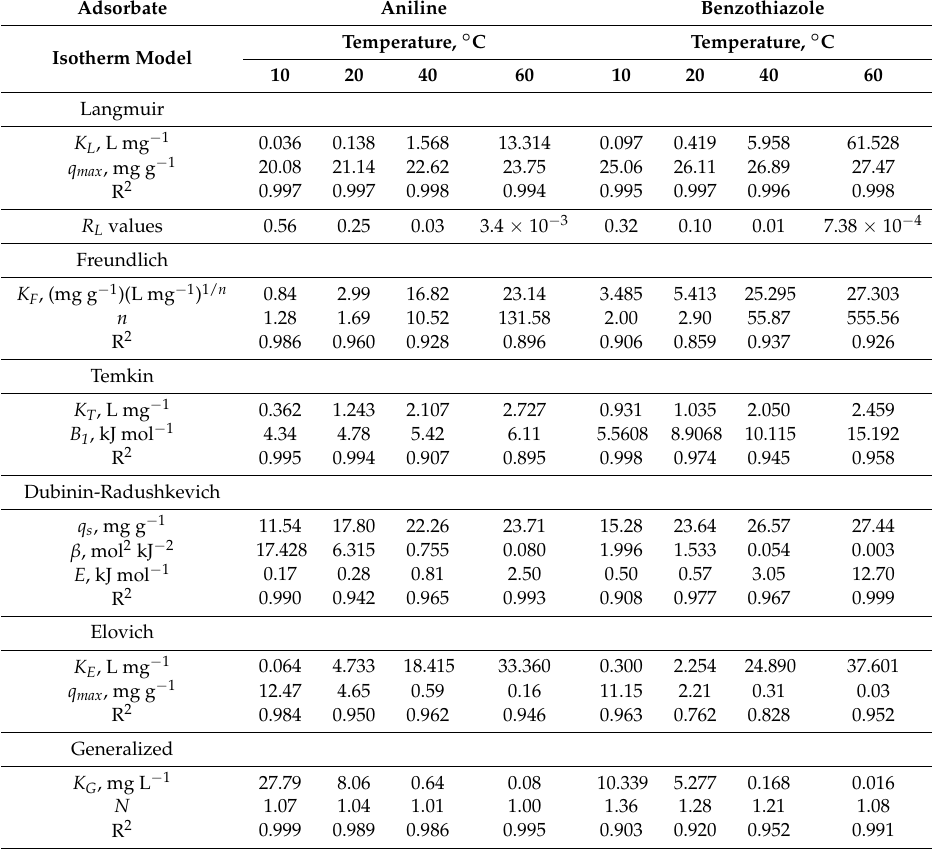
Table 2. Values of adsorption isotherm models for adsorption of aniline or benzothiazole onto TiO 2 at different